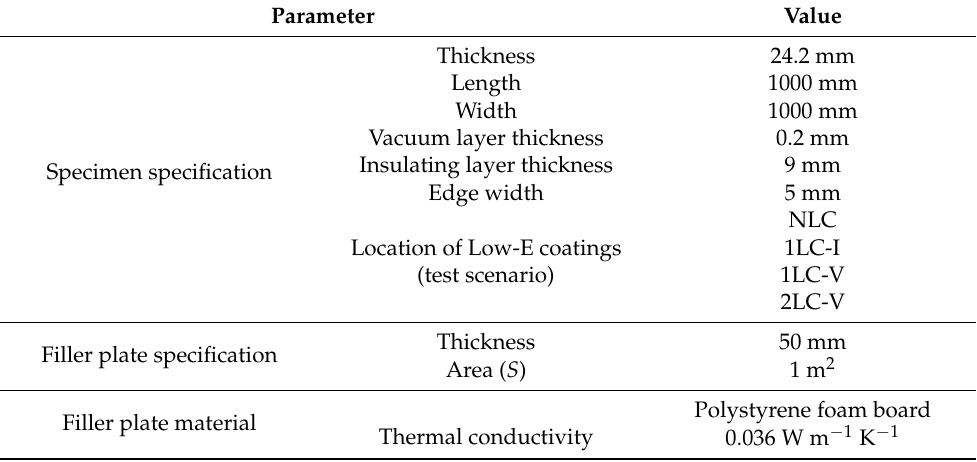
Table 4. Parameters of specimens.